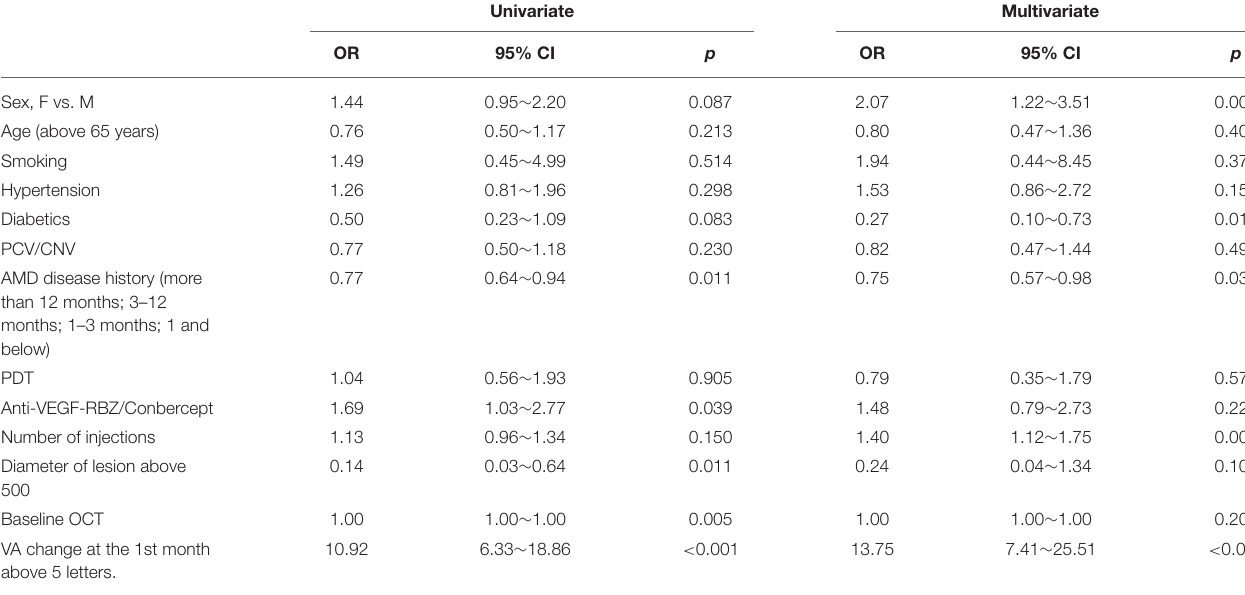
TABLE 5 | Univariate and multivariate